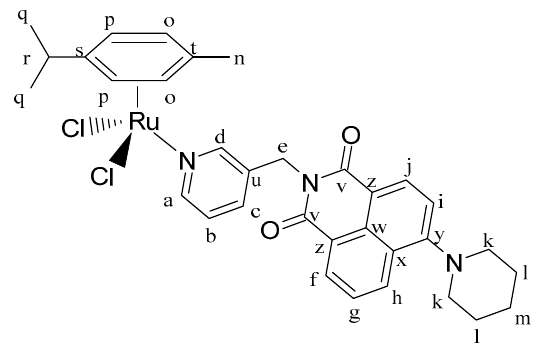
Figure 14 Structure of complex IC3. Figure 14. Structure of complex [( η 6-p-cym)Ru(L4)Cl2] (IC3) Figure 13 Structure of complex IC2.